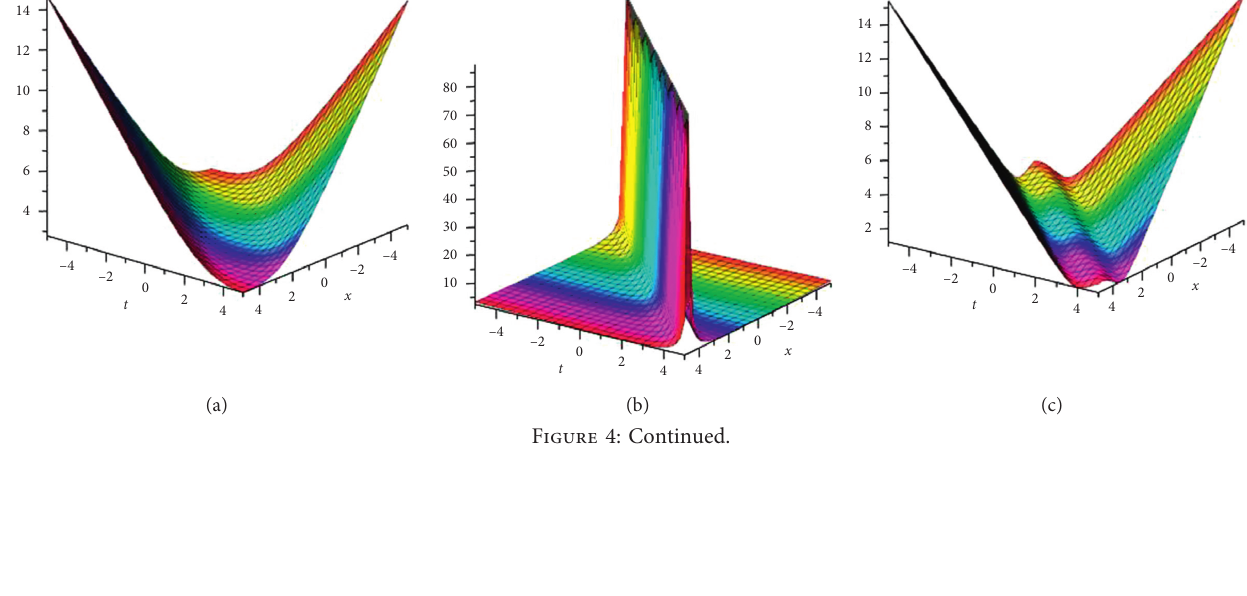
Figure 3: 3D profile of Family 15 with α � 1 . 5, β � 0, k � y � 1, ω � 0 . 5, p � q � 0 . 9, μ � 0 . 25, σ � 0 . 75, and A � 2 . 5. (a) | Φ | . (d) | Φ | . (e) | Φ | (c) | Φ 13 14 15